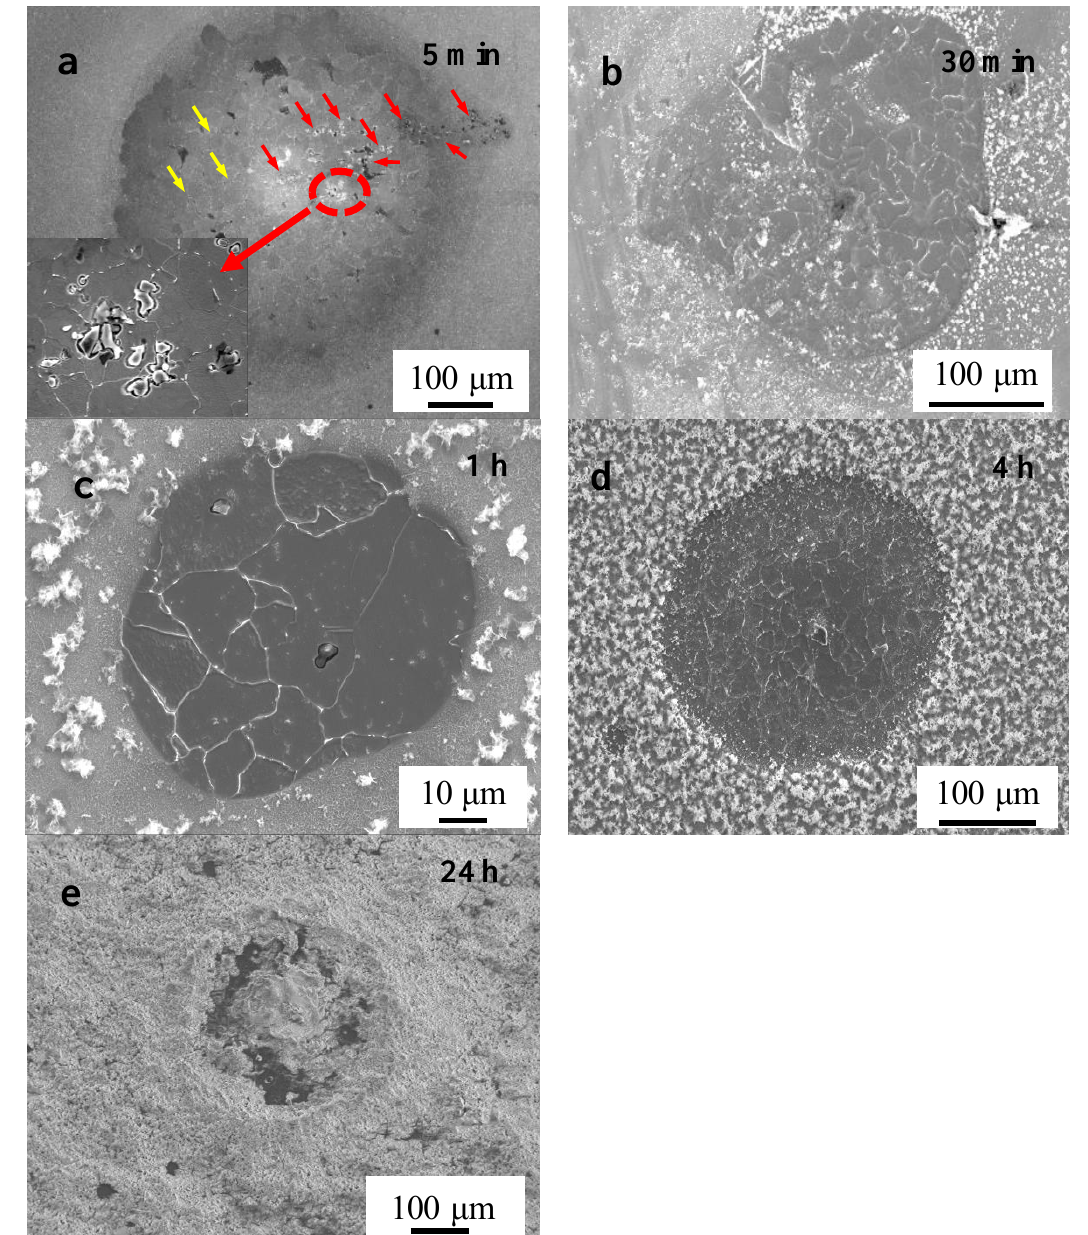
Figure 4. The morphology of localized corrosion on specimens after immersion test: ( a ) 5 min; ( b ) 30 min; ( c ) 1 h; ( d ) 4 h; and ( e ) 24 h.